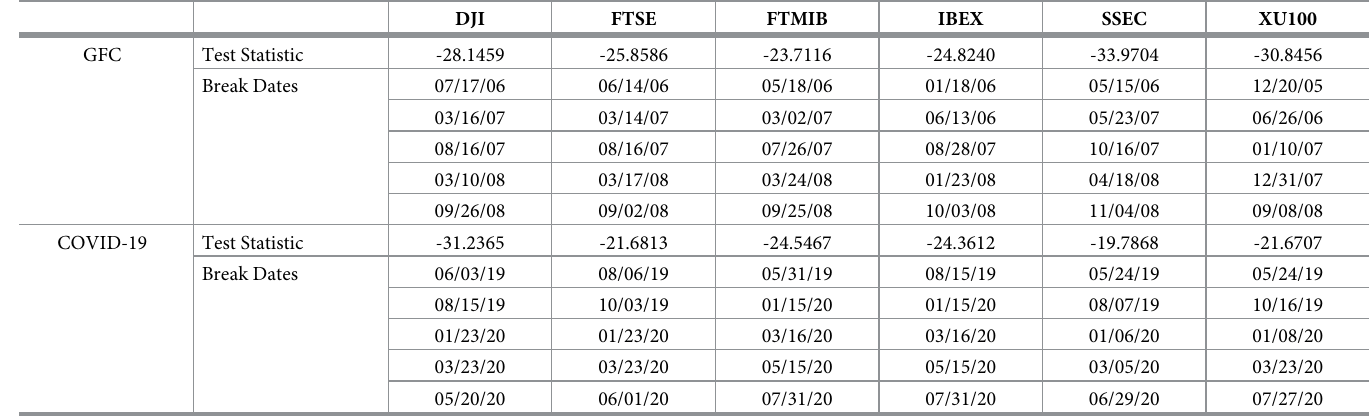
Table 2. Kapetanios m-break unit root test.